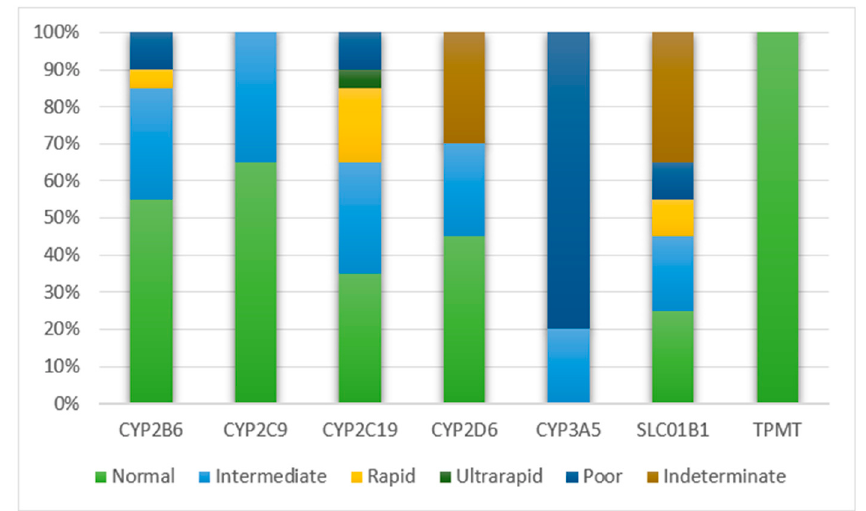
Figure 3. Metabolizer type for major pharmacogenes from 20 individual